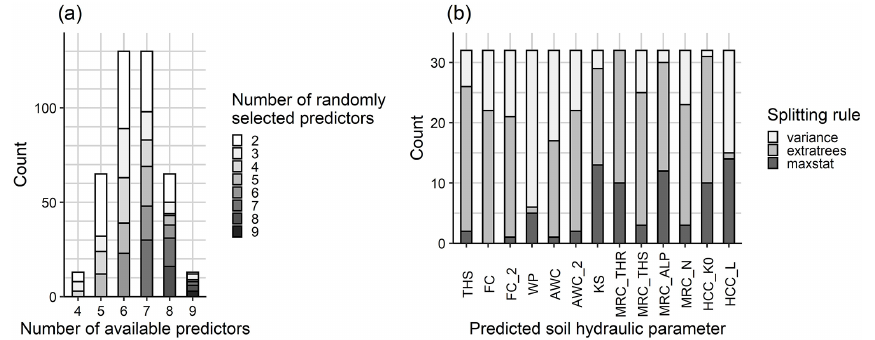
Figure 1. Results of parameter tuning of the random forest: optimization of (a) the number of randomly selected predictors at each split by number of available predictors and (b) splitting rule applied to build the trees in the random